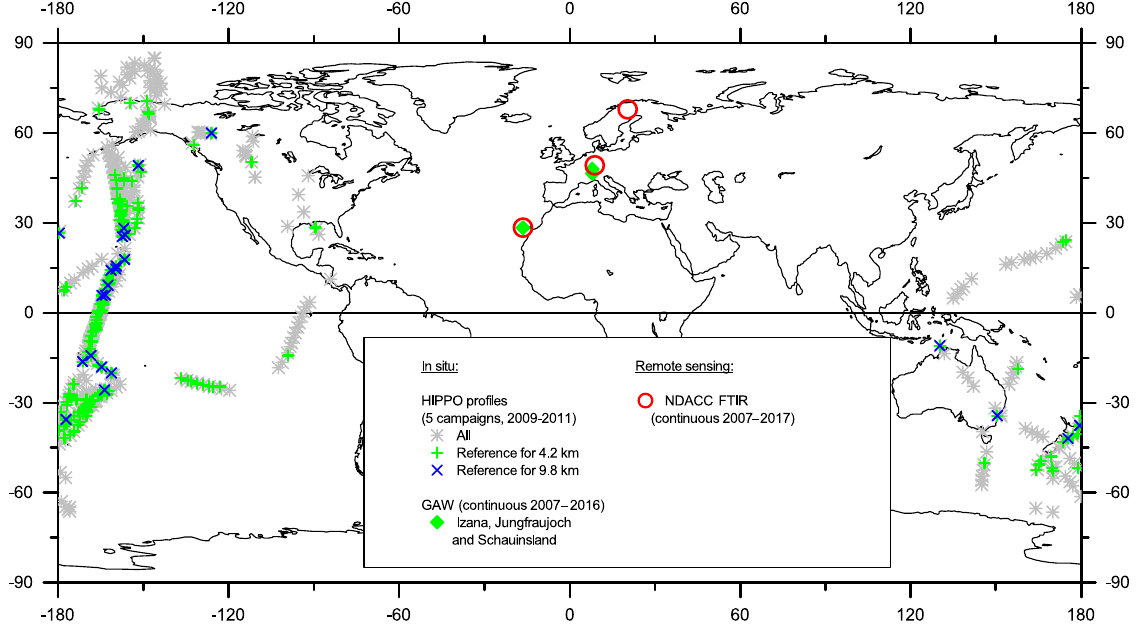
Figure 7. Overview on the locations and time periods with reference measurements used for validating the MUSICA IASI N 2 O and CH 4